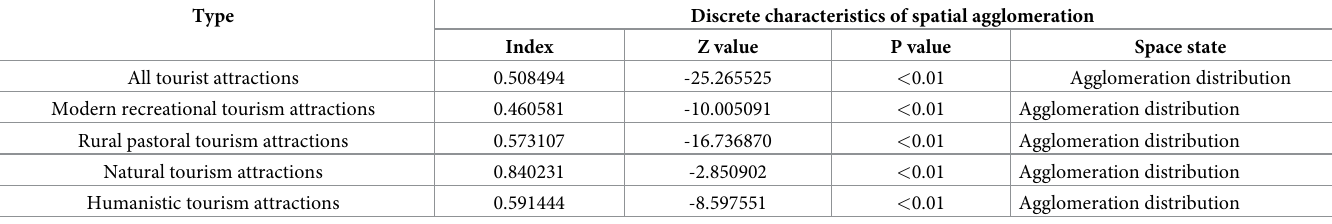
Table 3. The agglomeration discrete characteristics of tourist attractions in the demonstration